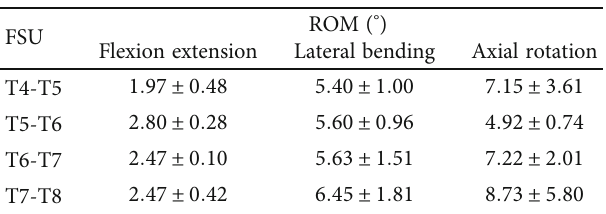
Table 3: Porcine spine data of the ROM for each DOF of each specimen at moment of ± 4Nm.